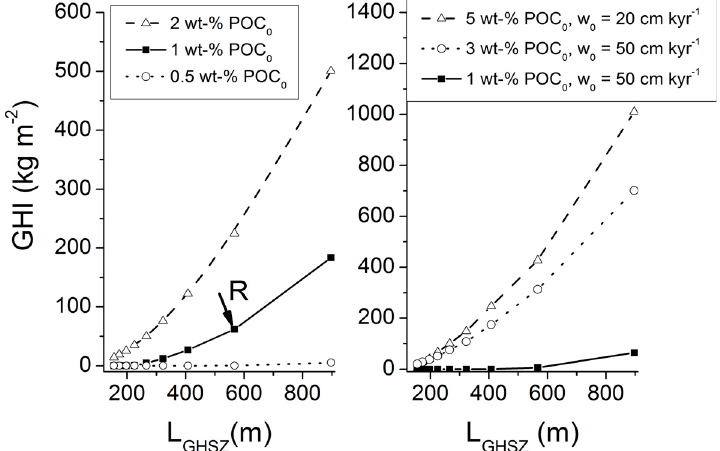
= 0.02–0.1 W m − 2 H = 134.6 cm kyr − 1 ). The 0 values. R indicates the reference 0